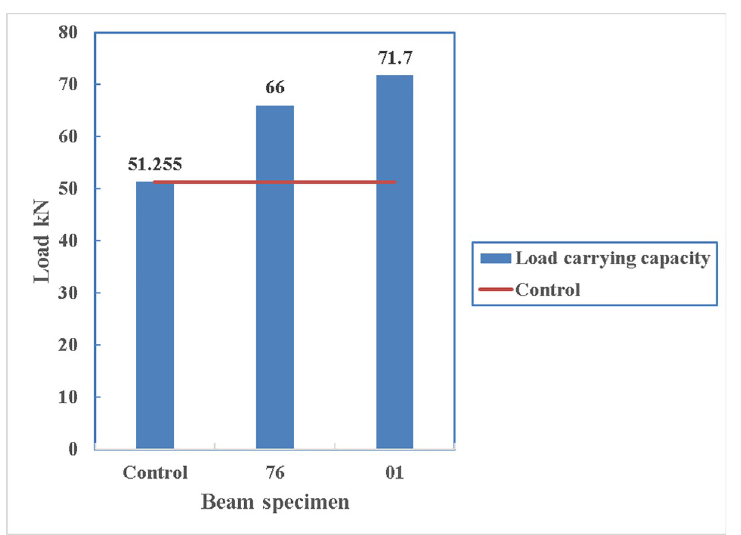
Fig 19. Comparison between beam 76 and beam